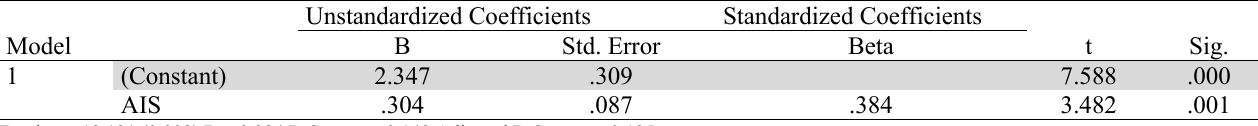
The summary of regression analysis on the effect of AIS on adding confidence and credibility to corporate governance outcomes